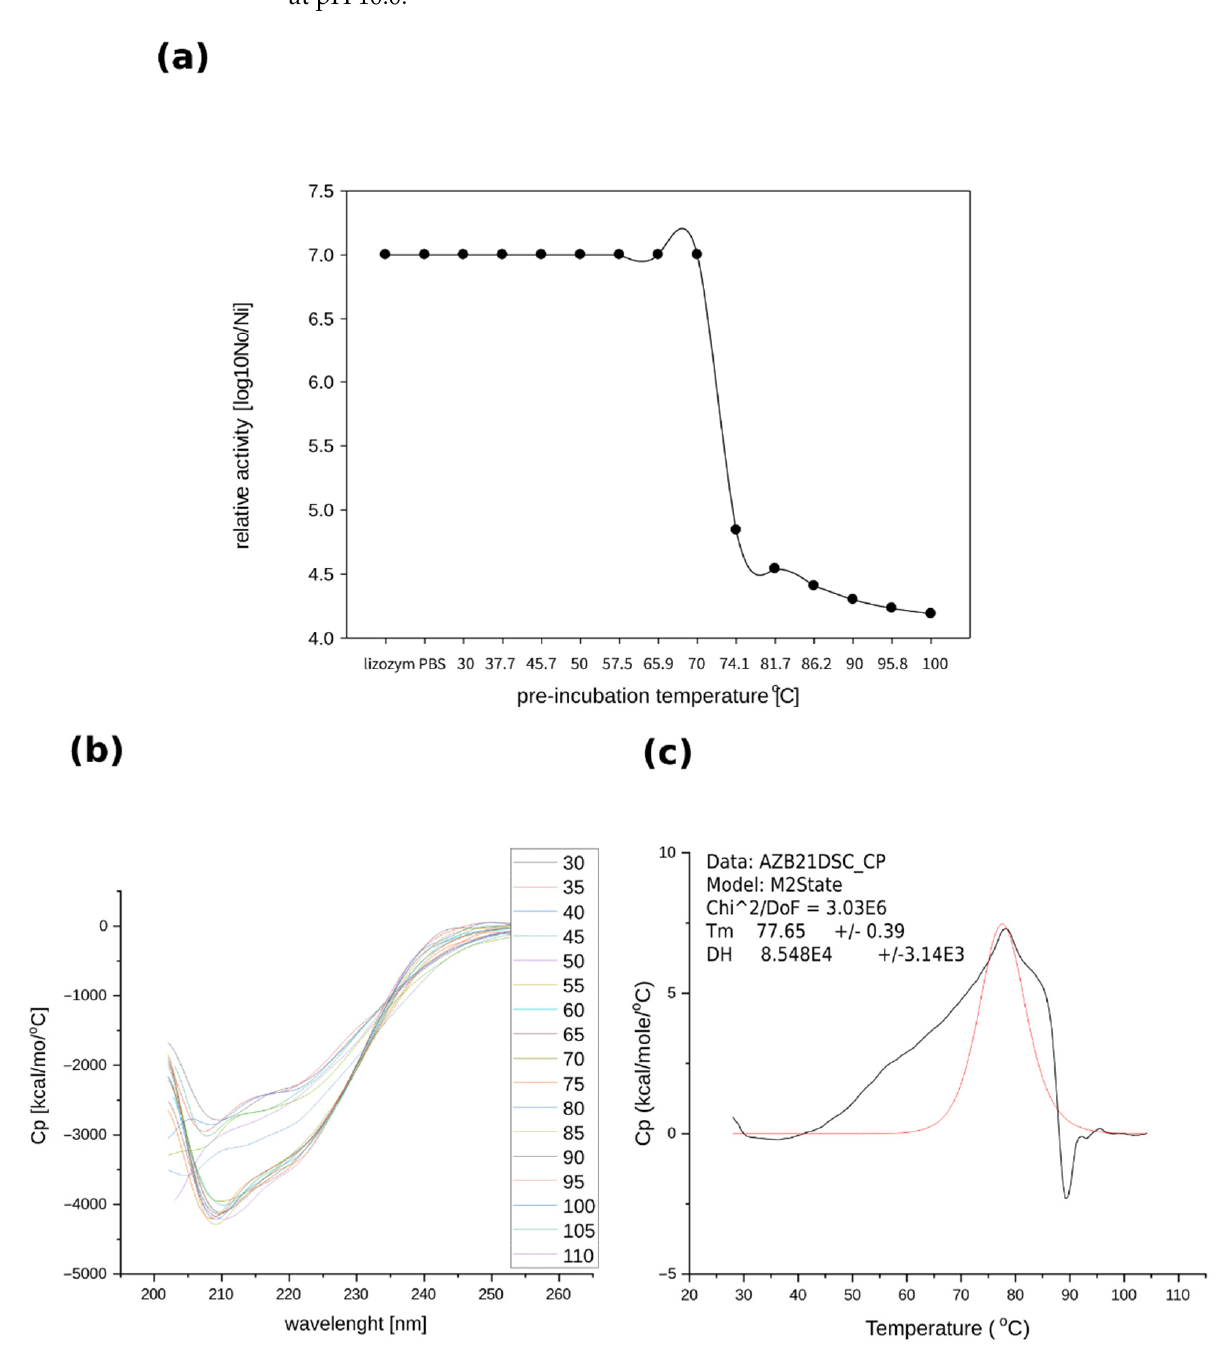
Figure 4. Determination of the thermal stability of recombinant TP84_28 endolysin. ( a ) TRA con- ducted on the pre-incubated enzyme and quantitative spectrophotometric measurements taken using a G. stearothermophilus strain 10 cell suspension; the dots represent the activity level of TP84_28 relative to the enzyme pre-incubation temperature ( b ) CD analysis; ( c ) DSC analysis; the heat-capacity curve of TP84_28 (black line) and the fit to the non-two-state model (red